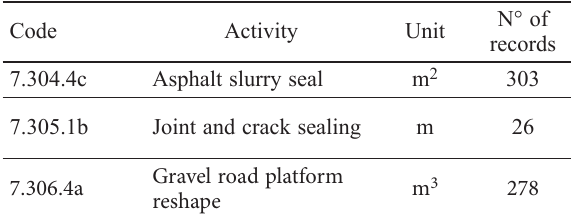
Table 1. Input data of example activities